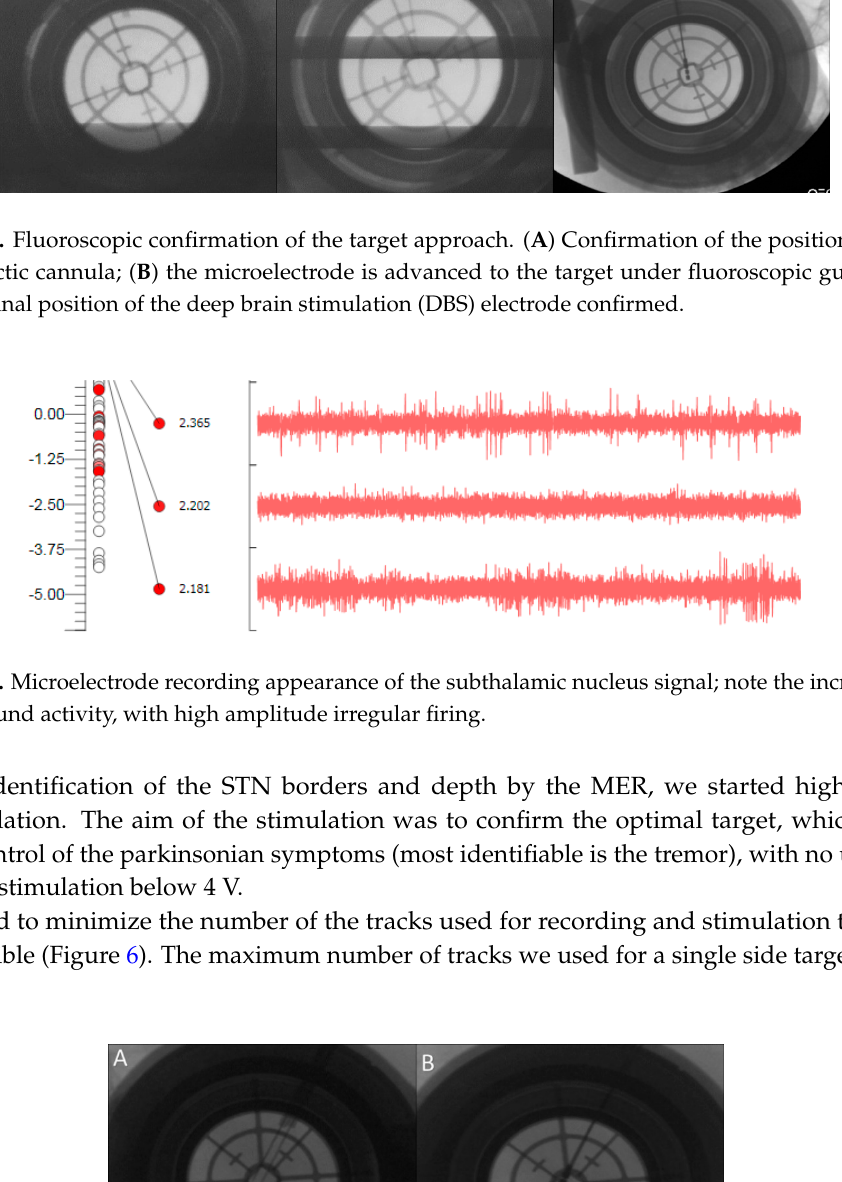
Figure 5. Screen shots from the Framelink software of the Stealthstation showing fused T1 and T2 MRI images of the patient and the planning process with identification of the posterior edge of the anterior commissure (AC) ( A ); the anterior edge of the posterior commissure (PC) ( B ); three midline points ( C – E ); and the final coordinates of the right subthalamic nucleus ( F ).